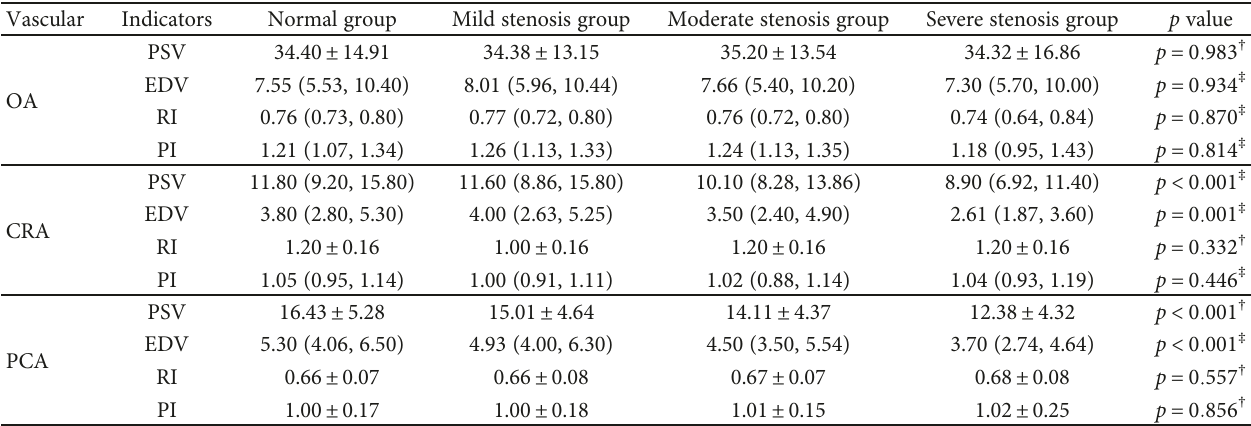
Table 3: Vascular haemodynamic parameters of major ocular